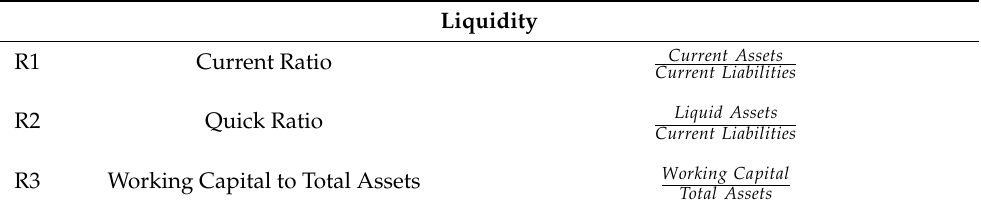
Table 2. Financial ratios used as initial